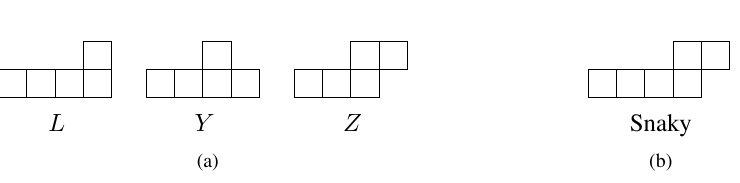
Figure 13: (a) Unbiased winners. (b) The only undecided polyomino.